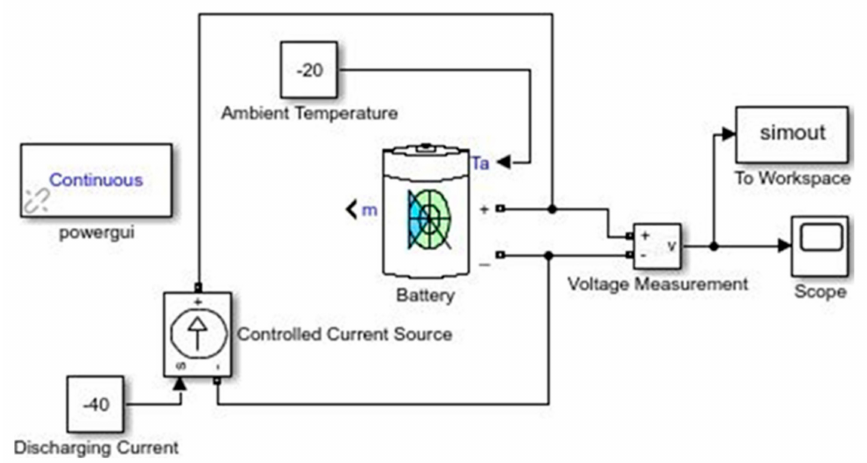
Figure 4. Battery cell thermal model in